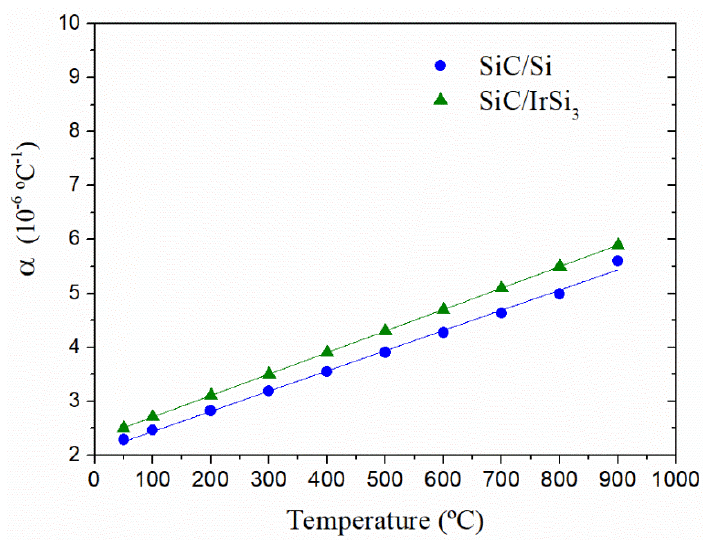
Figure 6. Evolution of thermal expansion coefficients, from 25 °C to 900 °C, of SiC-Si and SiC-IrSi 3 composite materials experimentally measured.